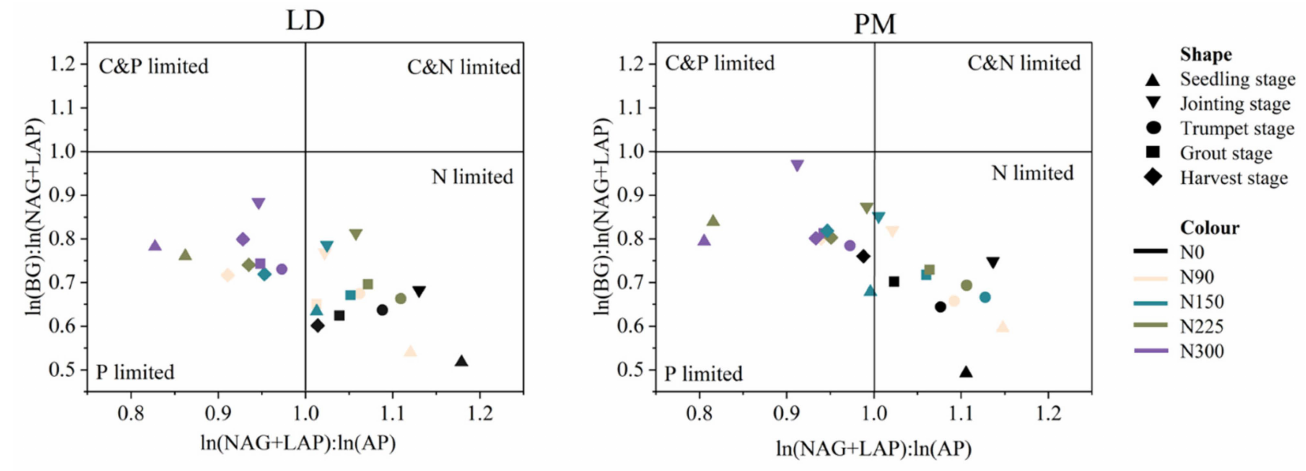
Figure 4. Stoichiometric ratio of soil enzyme activities at different nitrogen levels under the PM and LD treatments. C, soil organic carbon; N, total carbon; P, total phosphorus; N0, nitrogen application level was 0 kg · hm − 2 ; N90, nitrogen application level was 90 kg · hm − 2 ; N150, nitrogen application level was 150 kg · hm − 2 ; N225, nitrogen application level was 225 kg · hm − 2 ; N300, nitrogen application level was 300 kg · hm − 2 .